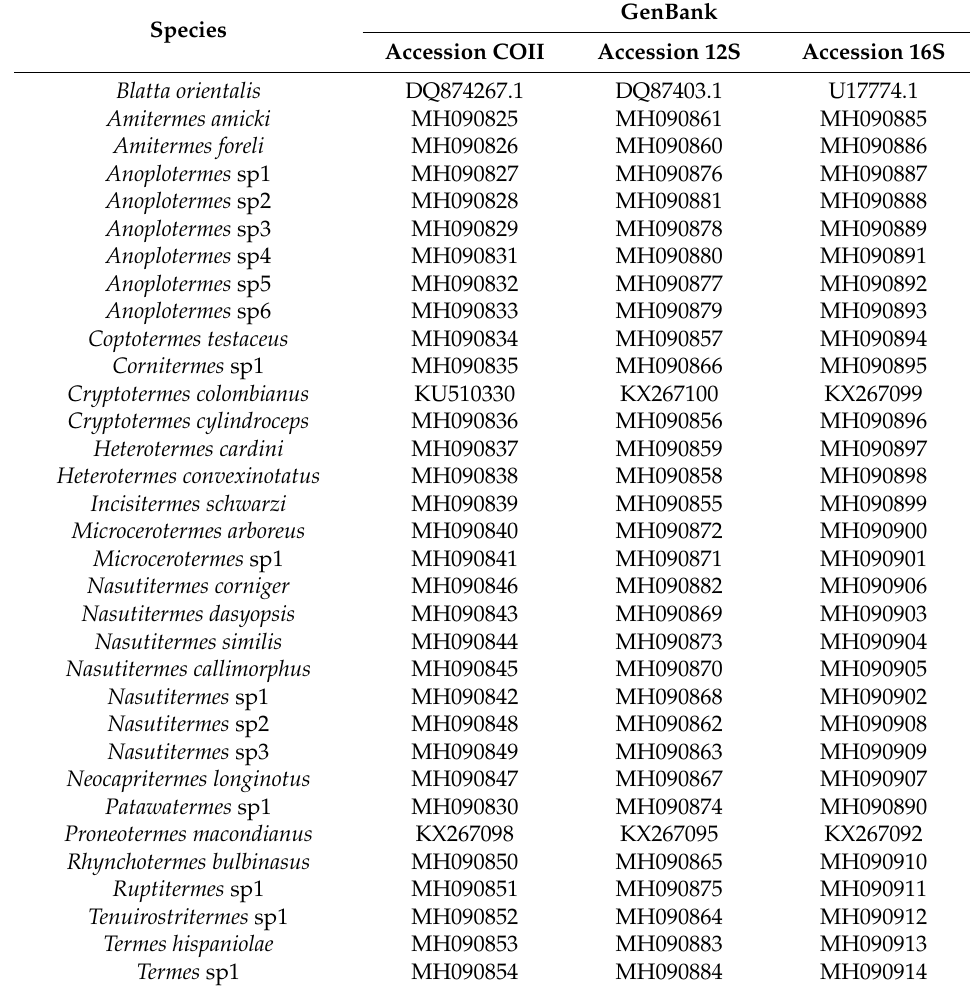
Table A1. GenBank accession numbers for all species for the COII, 12S, and 16S